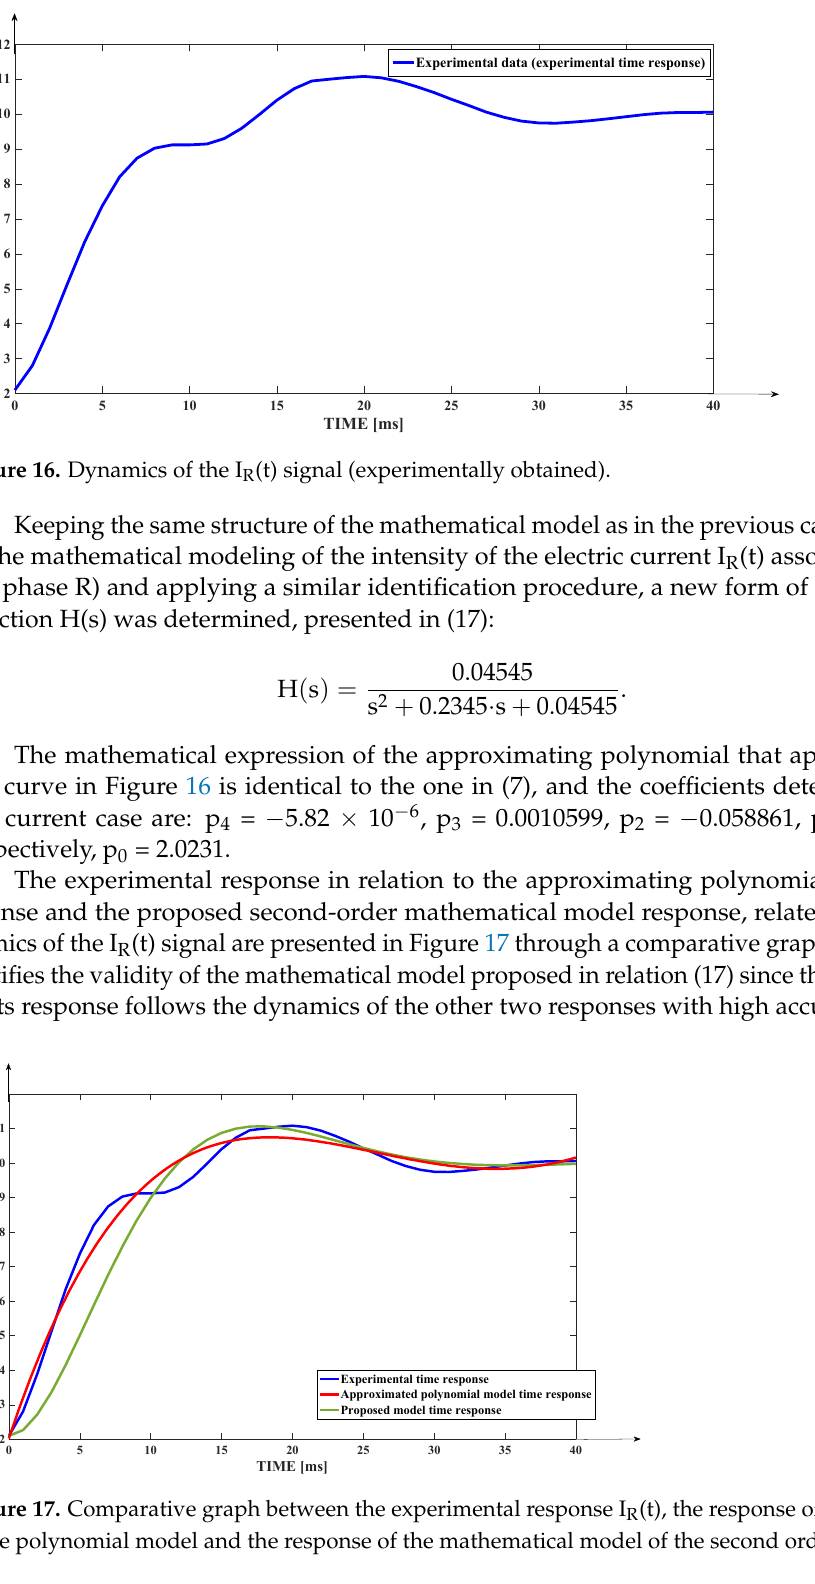
Figure 15. Comparative graph between the experimental response and the responses of the two identified mathematical models. By analyzing Figure 15, the conclusion is that the two proposed mathematical models present approximately the same degree of accuracy.